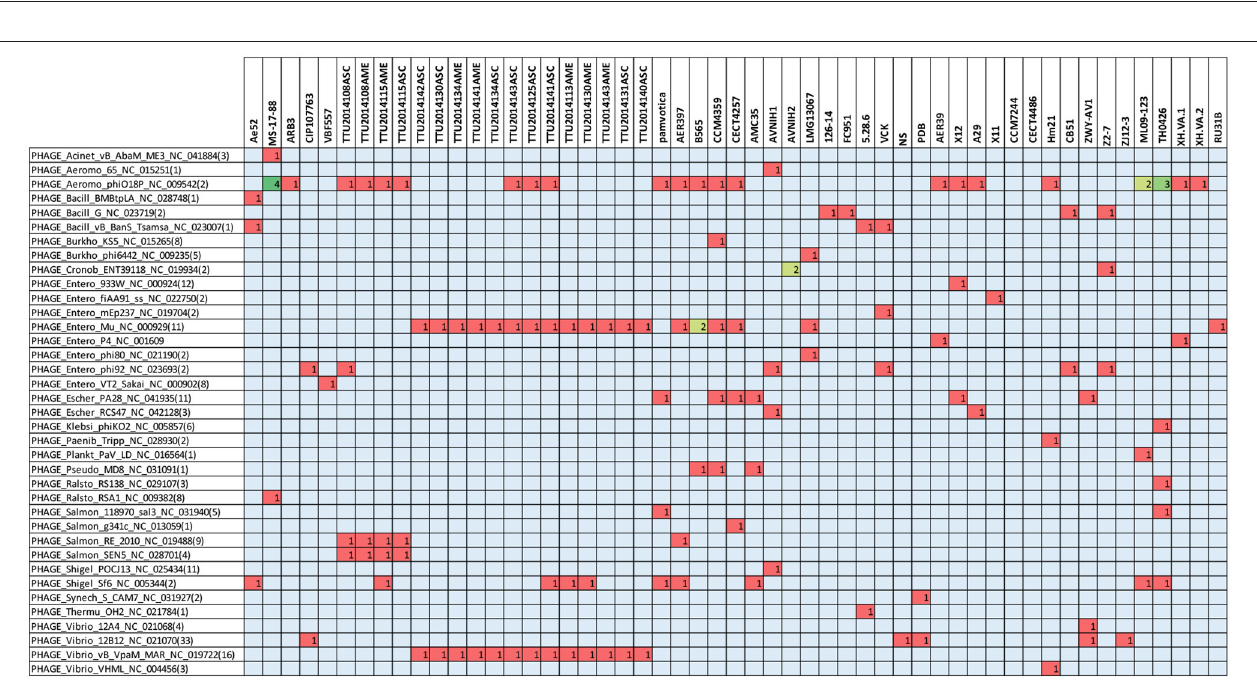
FIGURE 4 | Number of prophages with their completeness profiles in A. veronii genomes. Strains FC91, CCM7244, and CECT4486 did not have any prophage elements.